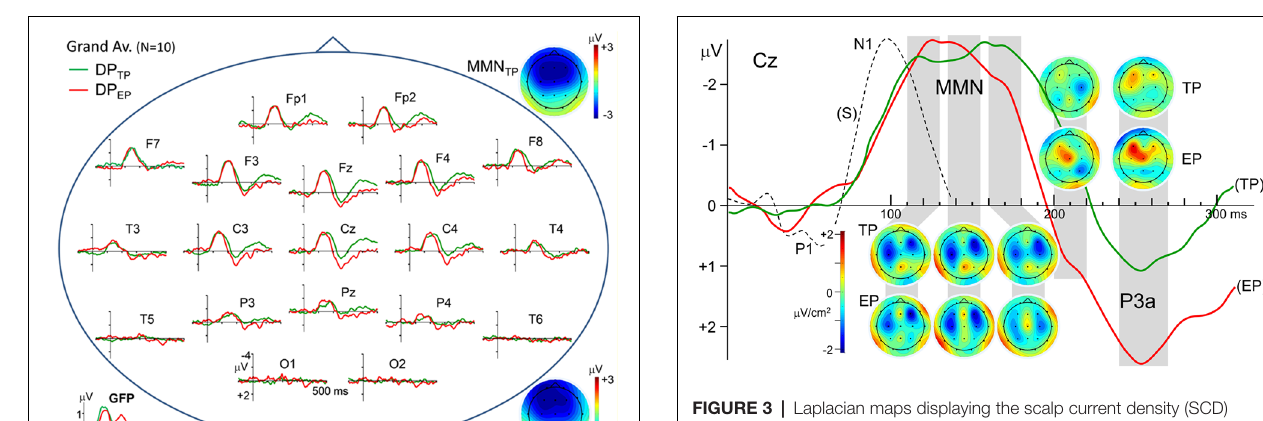
FIGURE 3 | Laplacian maps displaying the scalp current density (SCD) distributions of the Grand average MMN and P3a components in the ERPs to timely and earlier pitch deviances (TP and EP, respectively). Maps were obtained for the mean Laplacians over the time intervals indicated by gray stripes. Please note that the current density color scale is the same for all maps. N1 deflection of the ERP to standard stimulus is given in broken lines for comparison of its latency with the latency of